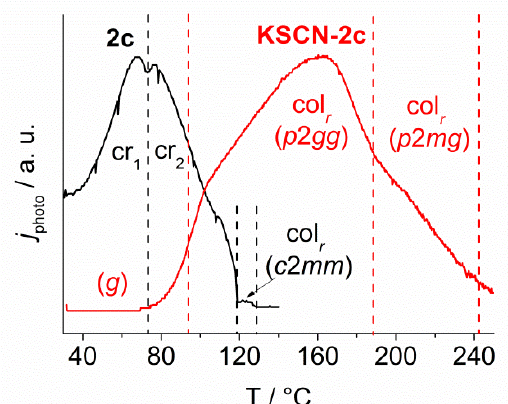
Figure 8. Typical normalized temperature dependent photoconductivity profile of KSCN-2c (red) and neat 2c (black). The phase transitions are depicted by the color coded vertical dashed lines for 2c and KSCN-2c. Neat 2c shows low photocurrent in the columnar phase ( c 2 mm ) and a significantly raised signal in both crystalline solid states Cr 1 and Cr 2 . The complex instead shows an “inverted” profile. The two columnar phases ( p 2 gg and p 2 mg ) provide significant photoconductivity while the signal vanishes completely in the glassy solid g . In both cases, no current could be detected in the isotropic melt.